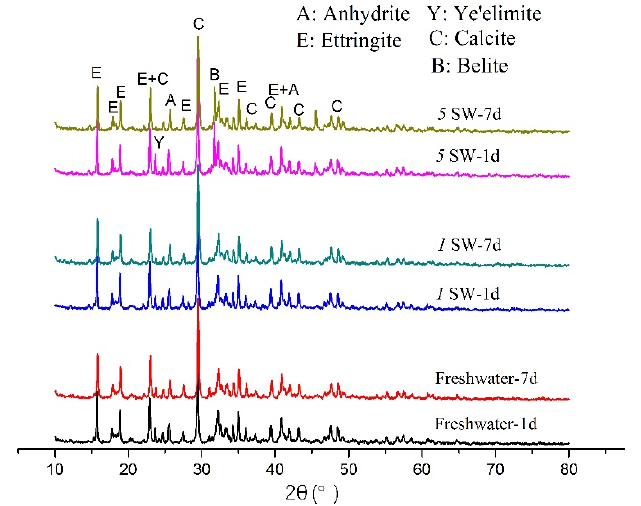
Figure 8. XRD patterns of the hydration products of CSA cement mixed with freshwater and sweater and cured at 1 d and 7 d.